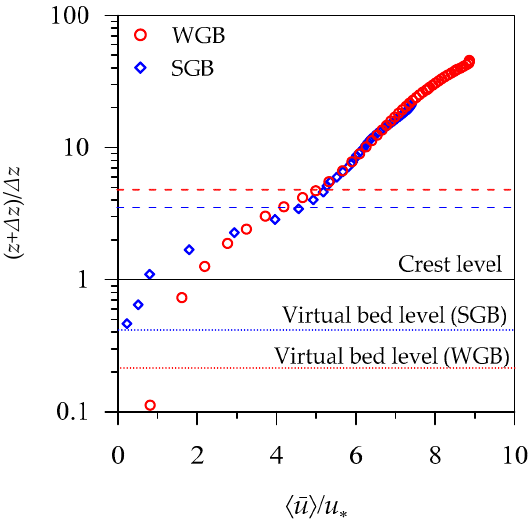
Figure 8. Variations of non-dimensional DA streamwise velocity with non-dimensional vertical distance ( z + ∆ z ) / ∆ z in the WGB and SGB. The red and blue broken lines indicate the form-induced sublayers in the WGB and SGB, respectively (data extracted from Padhi et al. [32]).